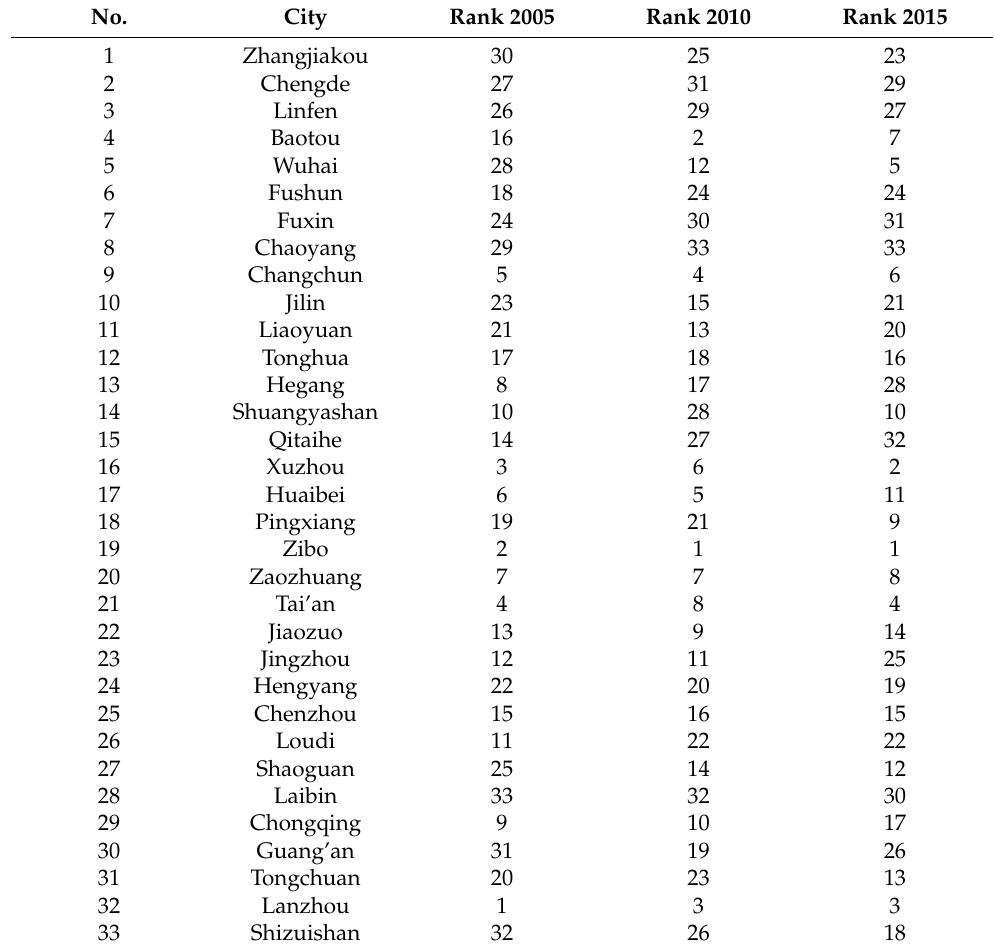
Table 11. Score and rank of green development of coal-resource-exhausted cities in 2005, 2010 and 2015.